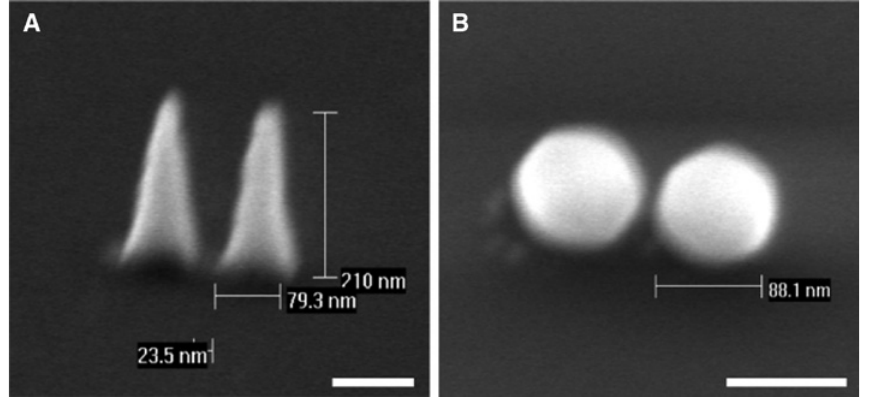
Figure 2: SEM images of the fabricated structures. (A) SEM image of a pair of nano-pillars with an aspect ratio of 2.5. (B) SEM image of annealed nano-pillars, which now assume a spherical shape. The images were taken at an angle of 75 ° . The scale bar is 100 nm in both SEM